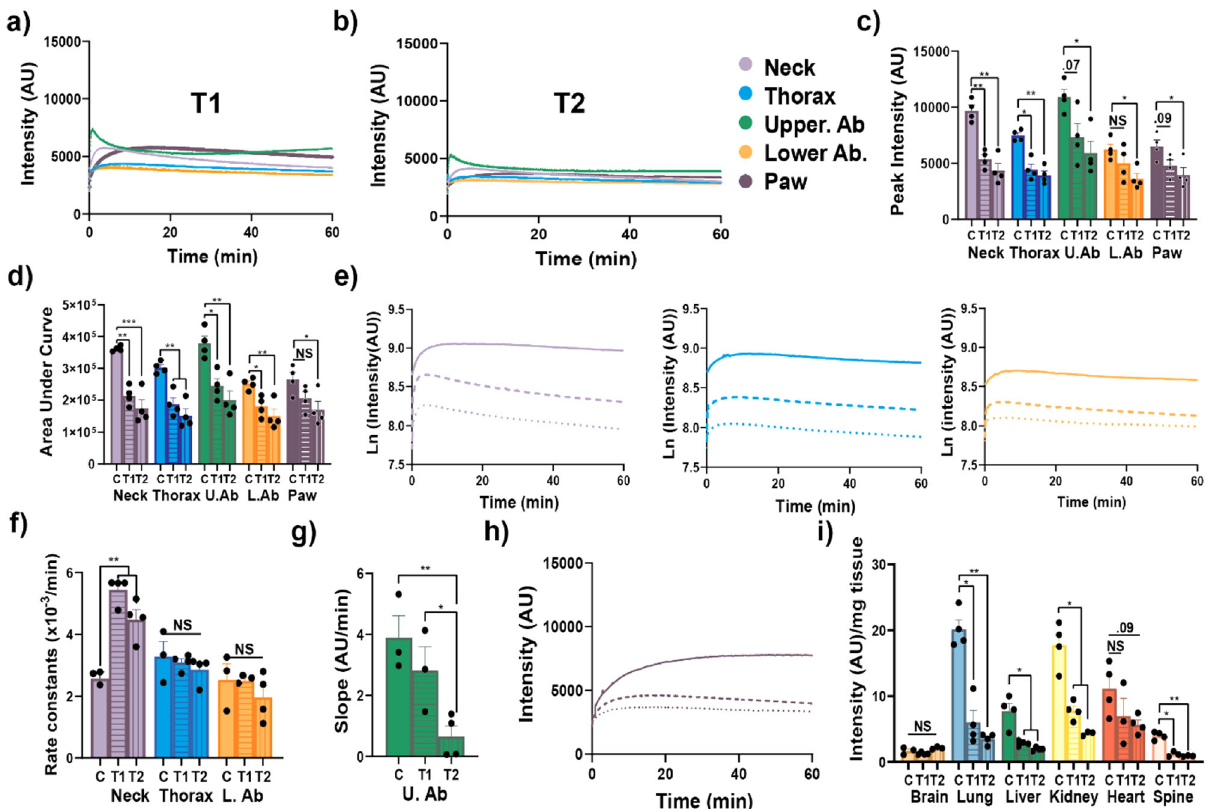
Fig. 2 Anti-ACE2 and anti-SP antibodies reduced SP biodistribution. a , b Representative SP-NIRF intensity-time pro fi le at the ROIs for T1 (anti-ACE2 antibody) and T2 (anti-SP antibody) in 2- to 3-month-old mice after its intravenous injection. c Peak intensity for the ROIs. d Area under the curve (AUC) for the ROIs. e Semi-Ln plots for the intensity-time pro fi le of the neck, thorax, and lower abdomen ROIs (continuous line (control); dashed line (anti-ACE2 antibody) and dotted line (anti-SP antibody). f Elimination rate constants for the neck, thorax, and lower abdomen. g Slopes for the accumulation phase for the upper abdomen. h Intensity-time pro fi le of the paw. i Organ SP-NIRF intensities/mg wet weight at 60 min. Values are mean ± SEM, N = 4 young male mice. AU (arbitrary